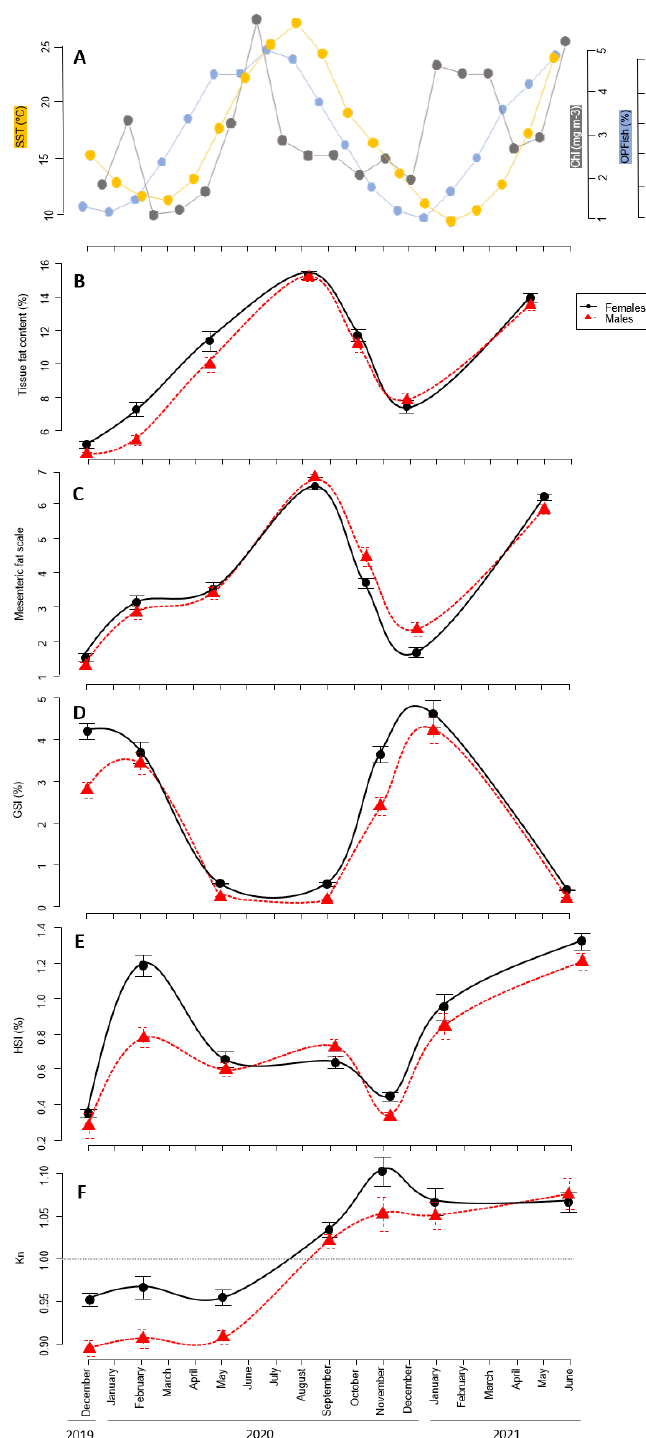
Figure 2. Condition analysis parameters in the European sardine ( S. pilchardus ) and the aver- ages of environmental variables along the Gulf of Trieste (North Adriatic, Mediterranean Sea). ( A ) Monthly mean sea surface temperature (SST ( ◦ C); yellow line), chlorophyll-a concentration (Chl (mg · m − 3 ); grey line), and available portion of productivity for the fish (OPFish (%); blue line) in the study area over the sampling time (2019–2021). ( B ) Tissue fat content (%), ( C ) Mesenteric fat scale, ( D ) Gonadosomatic index (GSI; %), ( E ) Hepatosomatic index (HSI; %), and ( F ) Relative condition factor (Kn) were estimated by sex (females, black line and dots; males, red line and triangles) as averages of the individual